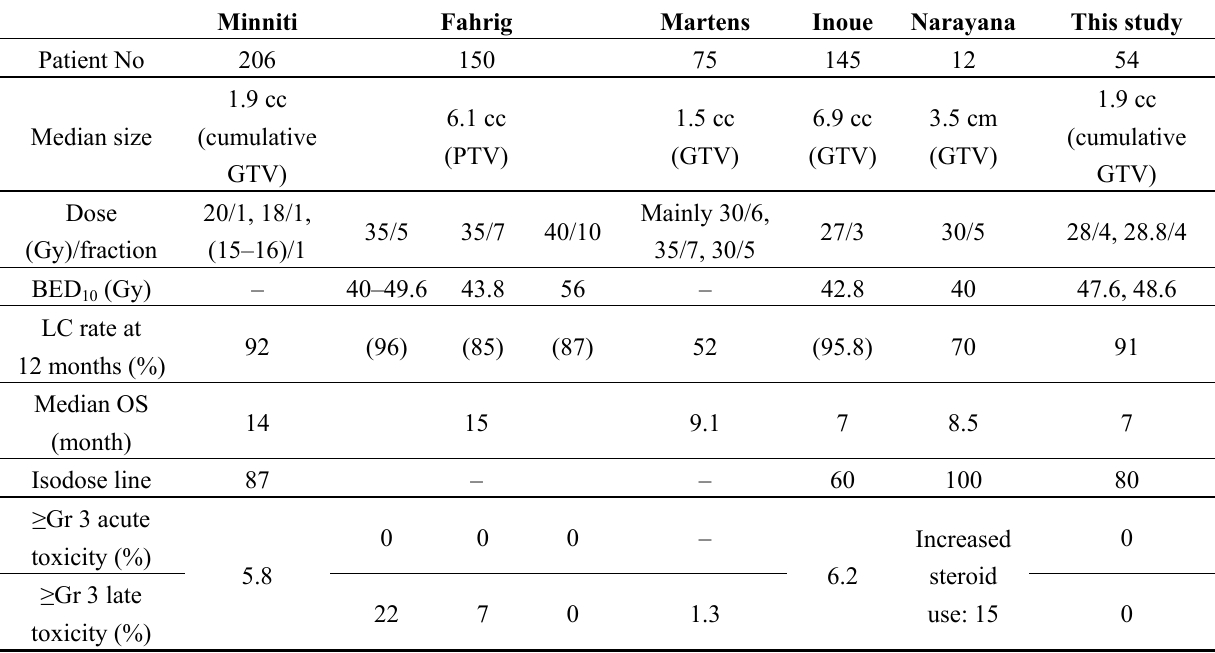
Table 6. Studies on stereotactic radiotherapy for brain metastases. Minniti